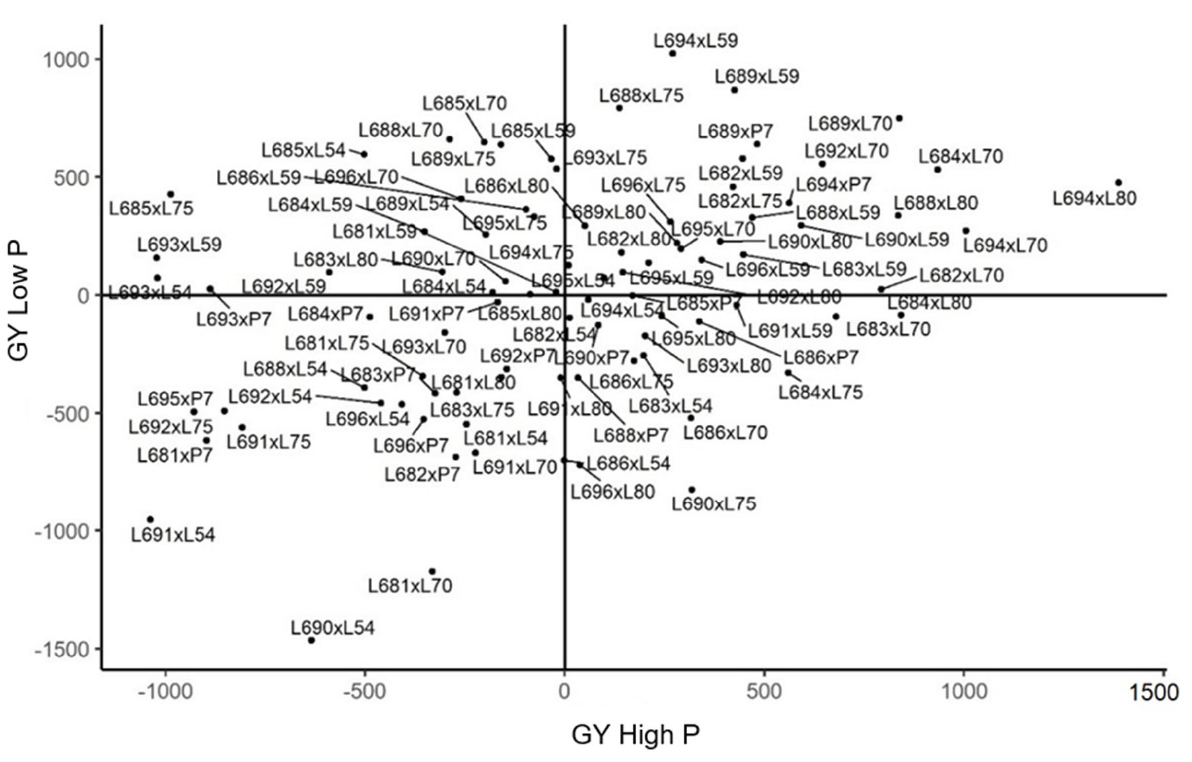
Figure 4. Estimates of the genotypic value (ˆ s ij ) for grain yield (GY) in diallel hybrids of popcorn evaluated under high and low phosphorus availability in Itaocara. ( − ) signal indicating negative